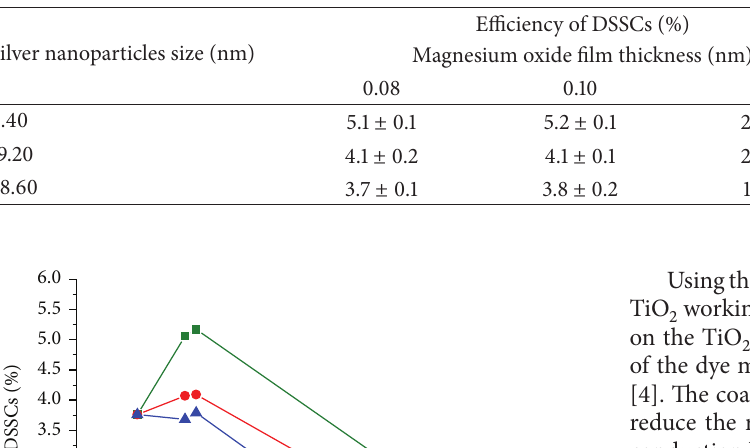
Table 1: Optimization of the TiO 2 /MgO/Ag composite films by varying the MgO thin film thickness and the Ag nanoparticles size for enhanced efficiency of the DSSCs.